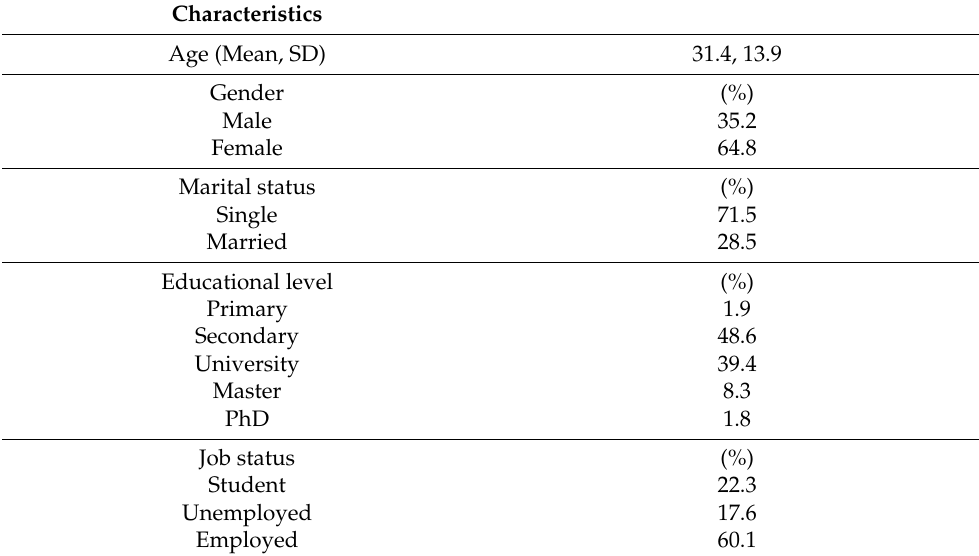
Table 1. Socio-demographic characteristics of the sample (Study 1, N = 627).